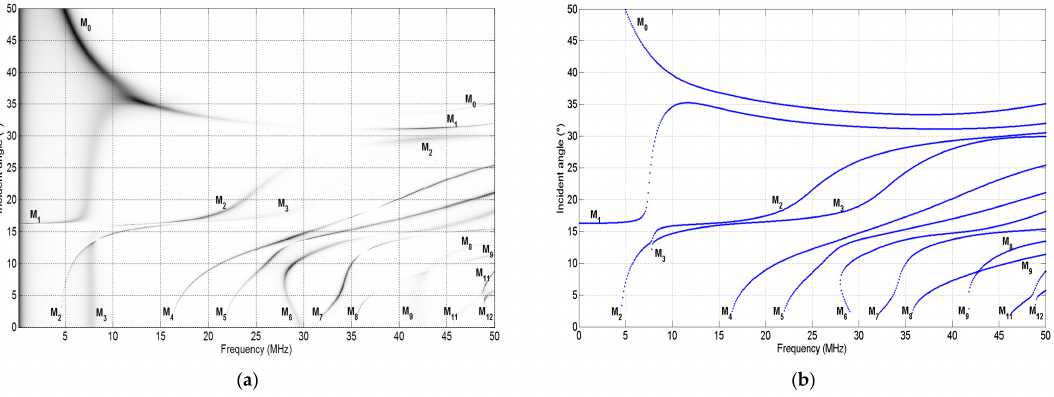
Figure 3. ( a ) Modulus of the reflection coefficient in the aluminum/epoxy/steel three-layer structure; ( b ) corresponding dispersion curves in the incident angle